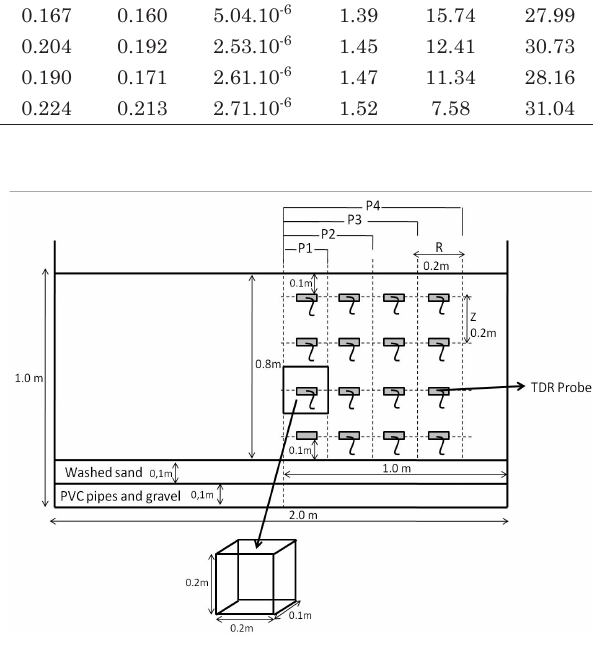
Figure 2. Array of probes in the profile for water monitoring in the